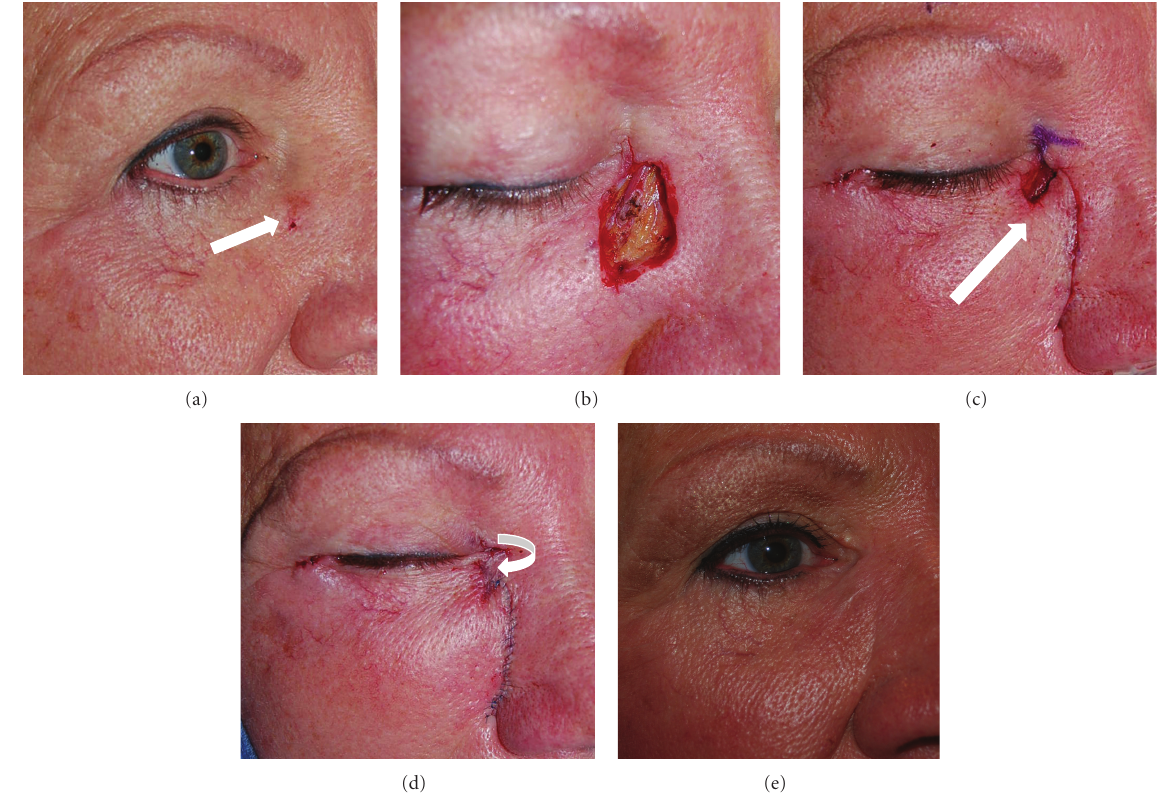
Figure 2: (a) Preoperative photo of a 62-year-old female with basal cell carcinoma of right medial canthus (arrow). (b) Local resection creating a 1.5 × 2.0cm defect. (c) Adjacent tissue transfer flap created via an infraciliary incision and relaxing incision at the lateral aspect of the nose. The flap is then advanced superiorly and medially (arrow) to fill in approximately 85% of the wound. (d) A small rhomboid flap is elevated from the upper lid and rotated inferiorly to fill in the remaining wound (arrow). (e) One year